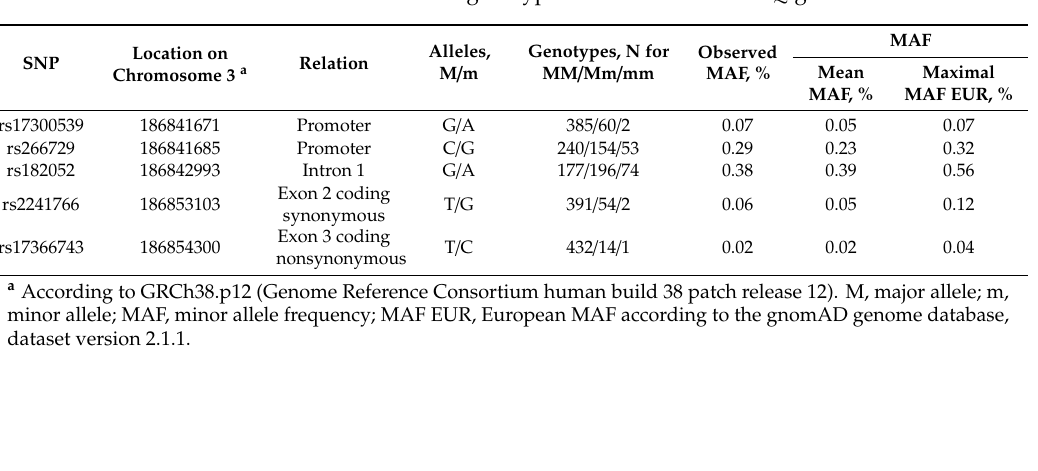
Table 3. Characteristics of the genotyped SNPs of the ADIPOQ